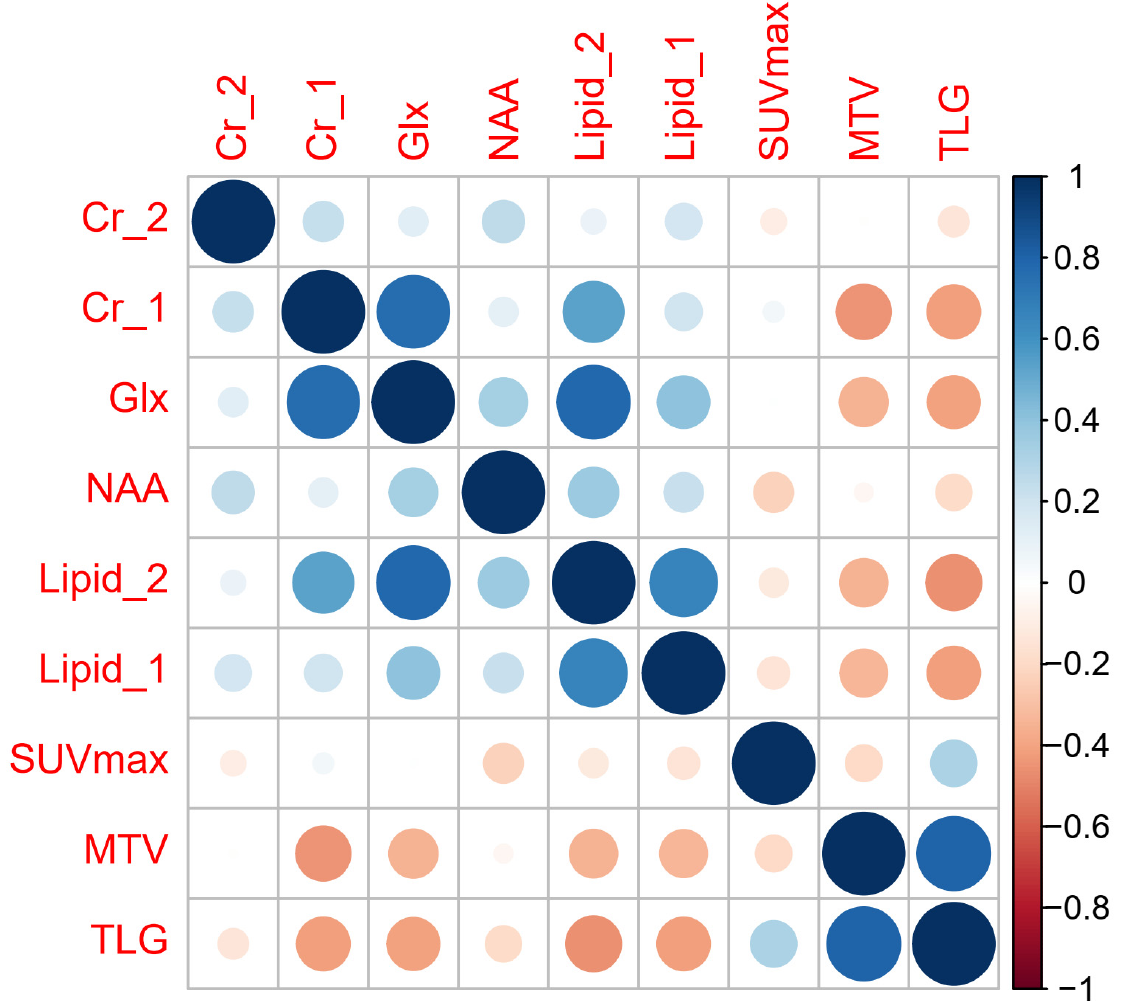
Figure 3. Correlation matrix of Spearman’s rank correlation coefficients. Size corresponds to strength of correlation.